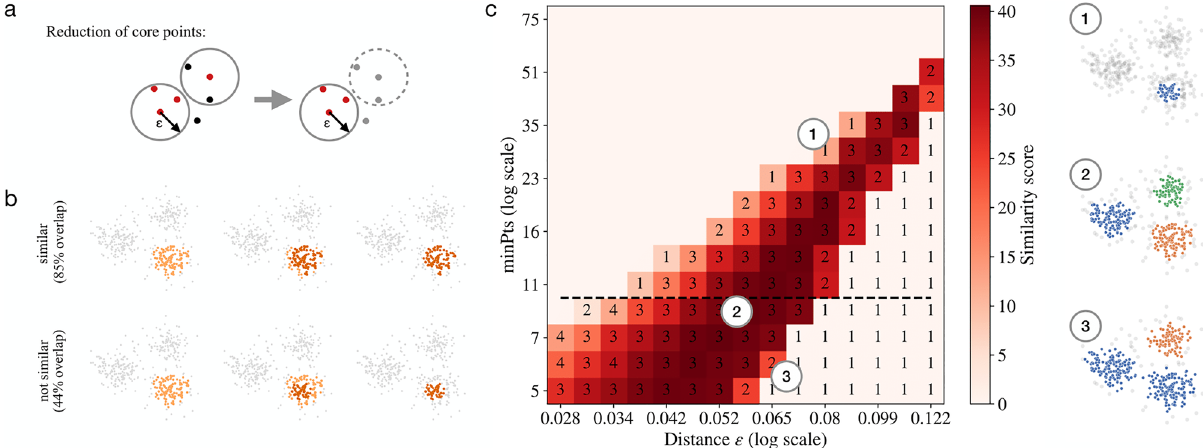
Figure 2. Schematics of FINDER algorithm ( a ) In DBSCAN, a new cluster is initiated when at least one core point (shown in red) is present that has at least minPts other points within distance ε from the core point (see circles, left). Inspired by DBSCAN, the clustering algorithm used in FINDER iteratively removes non-core points (shown in black) which results in a more frequent identification of noise localizations (grey points, right). ( b ) Two clustering assigments are considered similar, if the number of matching localizations is greater than the number of unmatched localizations. Example of two similar cluster assignments (top row) and two non- similar cluster assignments (bottom row). ( c ) Phase space of possible clustering outcomes. FINDER computes a similarity score among clustering results sharing the same value minPts (i.e., for each line on the plot, like the one highlighted with the dashed line). (1–3) represent three possible clustering outcomes within the parameter space. The parameters used for (1)-(3) correspond to the location of the respective number in the phase diagram,